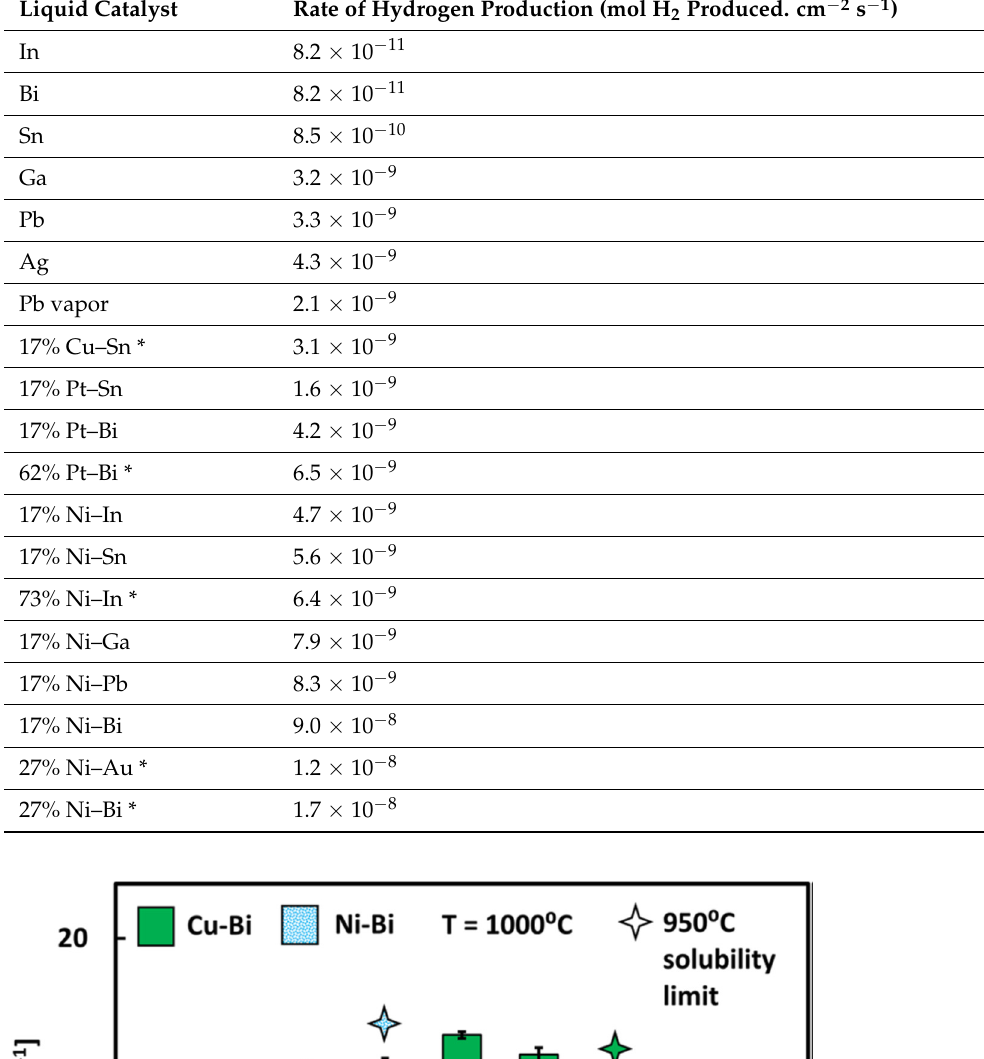
Table 5. Comparison of liquid catalyst activity for methane pyrolysis at 1000 ◦ C when CH 4 is flowed over 38.5 mm 2 of molten metal in a differential reactor. (*) indicates that alloy is at the solubility limit of the dissolved active metal at 950 ◦ C.